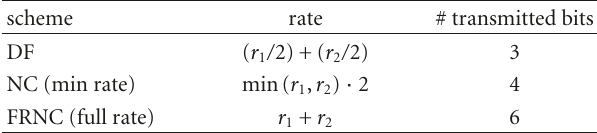
Table 2: A comparison of the broadcast channel among three schemes, for the scenario shown in Figure